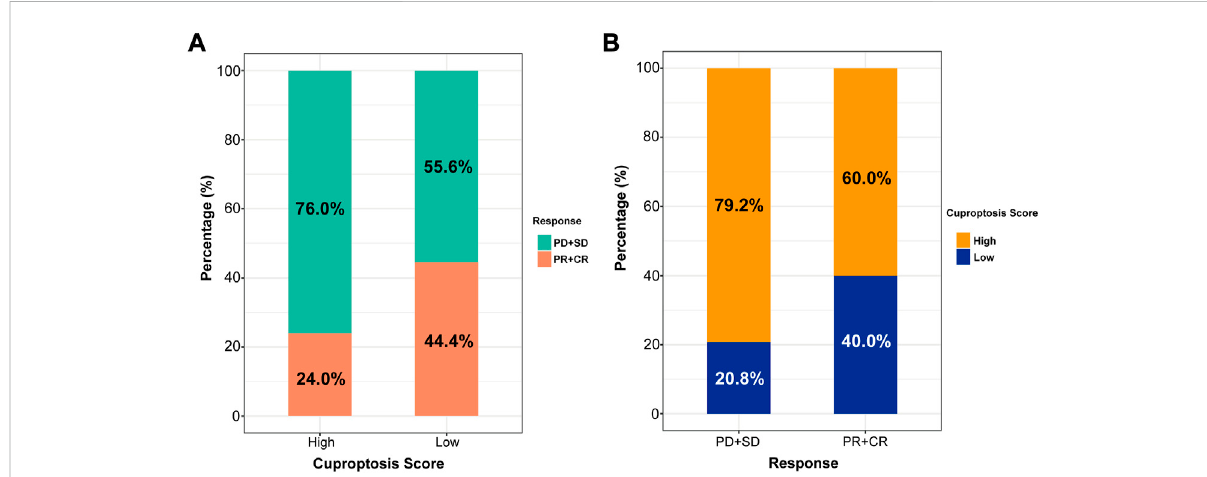
FIGURE 8 Theroleofcuproptosisscore inanti-PD-1immunotherapy. (A)